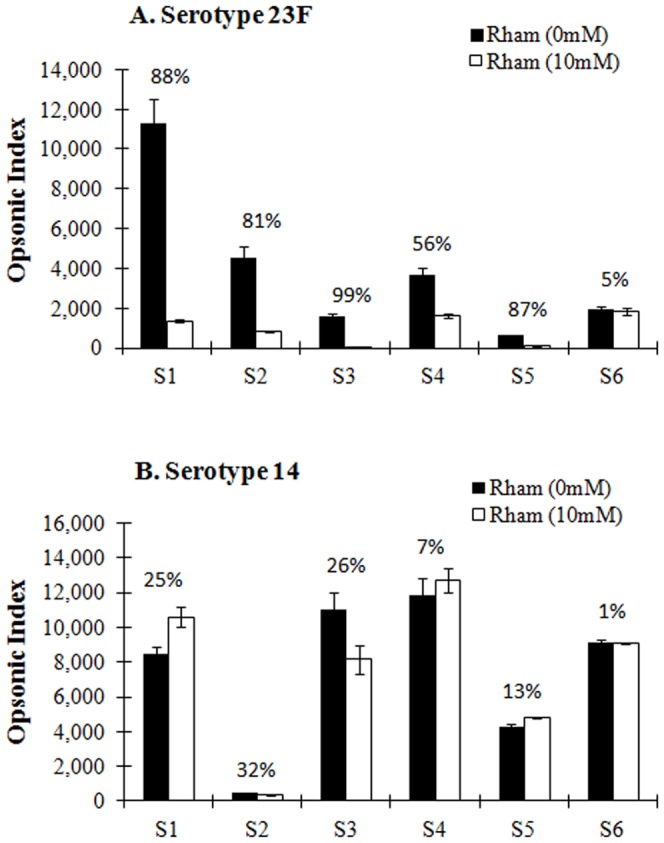
Changes in opsonic index after inhibition by rhamnose.Opsonic capacities of serum samples obtained from adults (S1–S6) immunized with PPV23 were measured in the presence or absence of 10 mM L-rhamnose against pneumococcal serotype 23F (A) or 14 (B). Each serum sample is shown as S1, S2, S3, S4, S5 and S6. The numbers (%) indicate the percent change of opsonic indices in the presence of 10 mM L-rhamnose. Data shown are the mean ± standard error (SE) of two independent experiments.